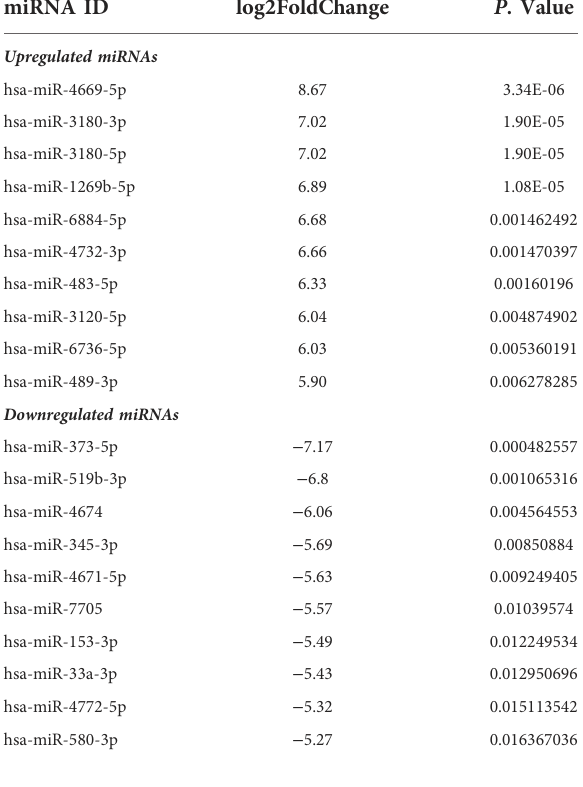
TABLE 1 The top 10 DEmiRNAs in exosome of MPE compared to TPE. miRNA ID log2FoldChange P .